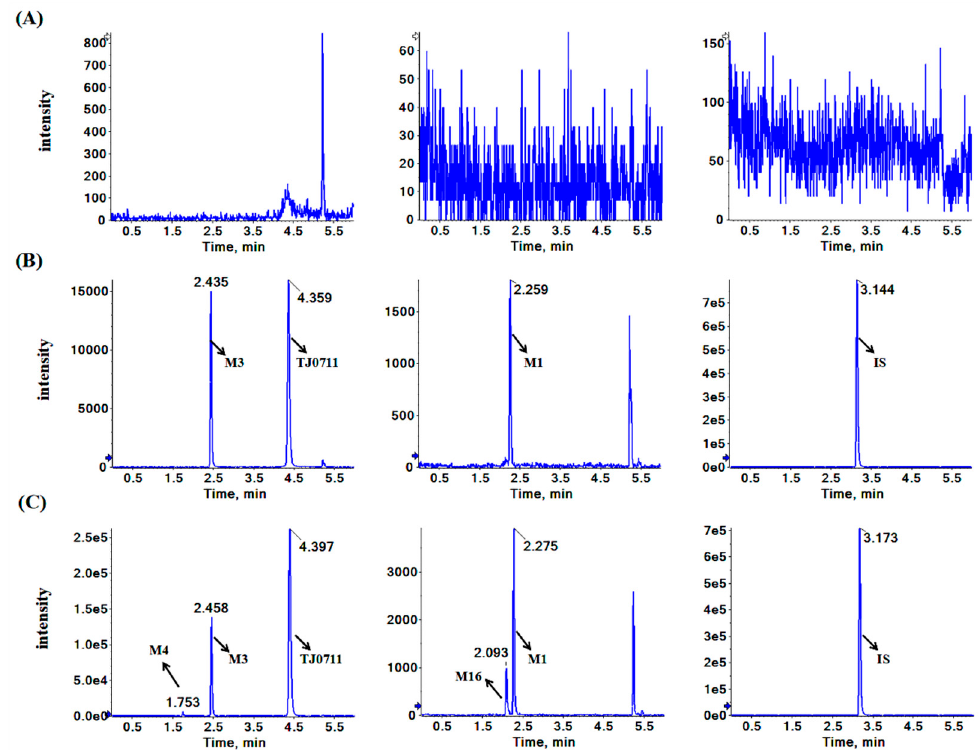
Figure 3. Representative multiple reaction monitoring chromatograms of TJ0711, M1, M3, and IS in dog plasma: ( A ) double blank dog plasma, ( B ) a plasma sample of LLOQ containing TJ0711 M1, M3, and IS, and ( C ) a plasma sample collected at 120 min after intravenous infusion of 3 µ g/kg/min TJ0711 in dog (The concentrations were calculated to be 62.5, 0.835, and 28.6 ng/mL for TJ0711, M1, and M3, respectively).